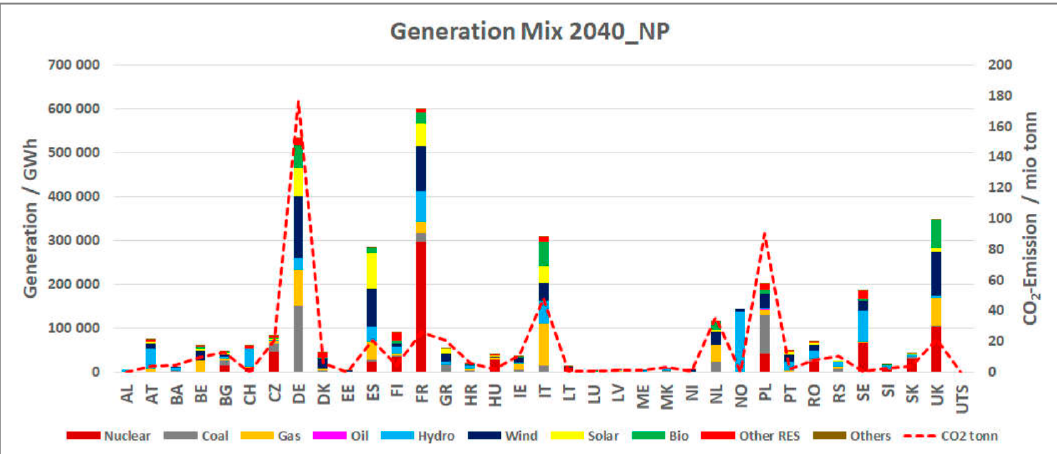
Figure 9. Generation mix and emissions for all countries in the NP scenario for the year 2040. The following countries and power consumers are included: Albania (AL), Austria (AT), Bosnia